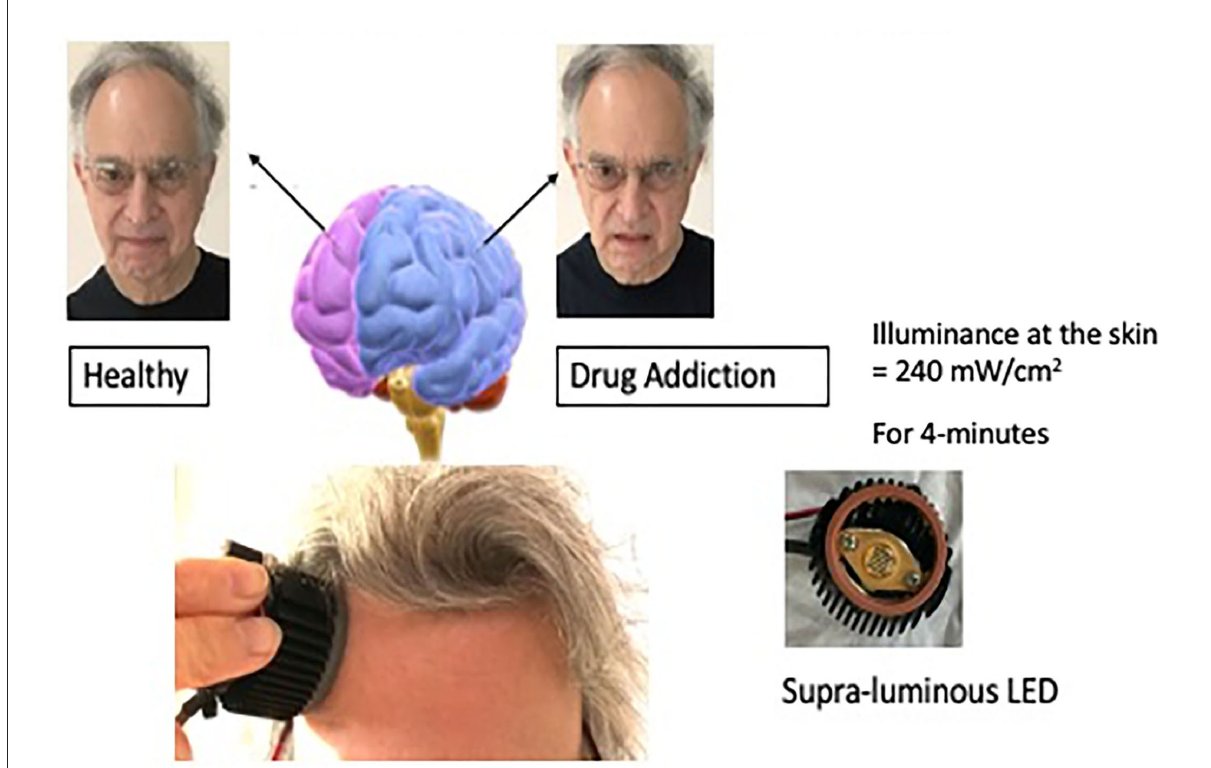
FIGURE3 This illustration depicts unilateral transcranial photobiomodulation over the positive hemisphere. The clinical vignette presented above contains an exerted transcript of a woman while she was being treated over her left hemisphere. An earlier paper presented additional transcripts with case material (Schiffer,